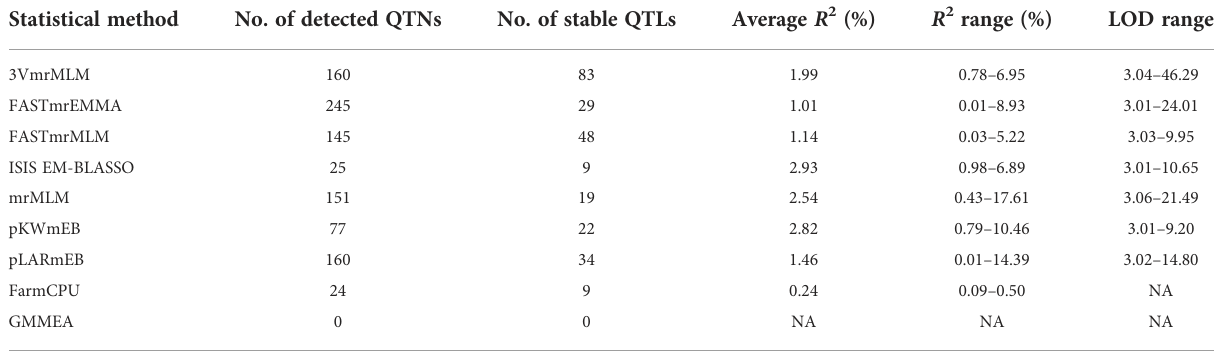
TABLE 2 Comparison of QTN/QTL identi fi cation for different GWAS methods.